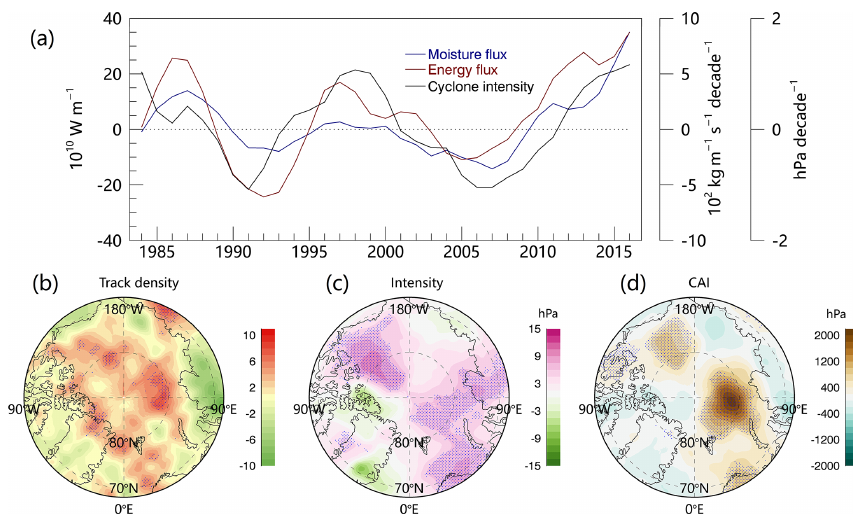
Figure 10. (a) The time series for the trends of the meridional total energy (moisture) transport and average intensity of poleward cyclone during the spring months (April to June) from 1979 to 2020. The trends are calculated using a 10-year running window. Note that the northward transport is the average value of all the corresponding fluxes across 50–70 ◦ N, which is consistent with the definition of poleward cyclones. The values of the x axis correspond to the central years of each running window. Anomalies of the cyclone features in spring 2020 relative to the 1979–2020 climatology, including the (b) density of tracks, (c) intensity, and (d) CAI, are shown. Panels have units of counts per 10 6 km 2 (b) and hPa per 10 6 km 2 ( c and d ). Blue dots represent the regions with values above the mean plus 1.5 standard